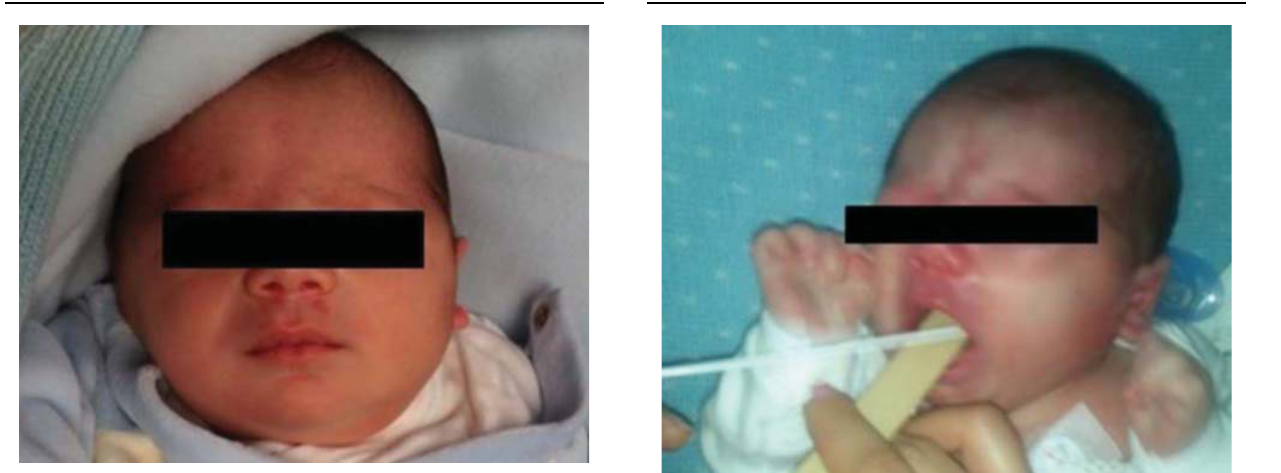
Swelling in the left parotid region with inflammatory signs.